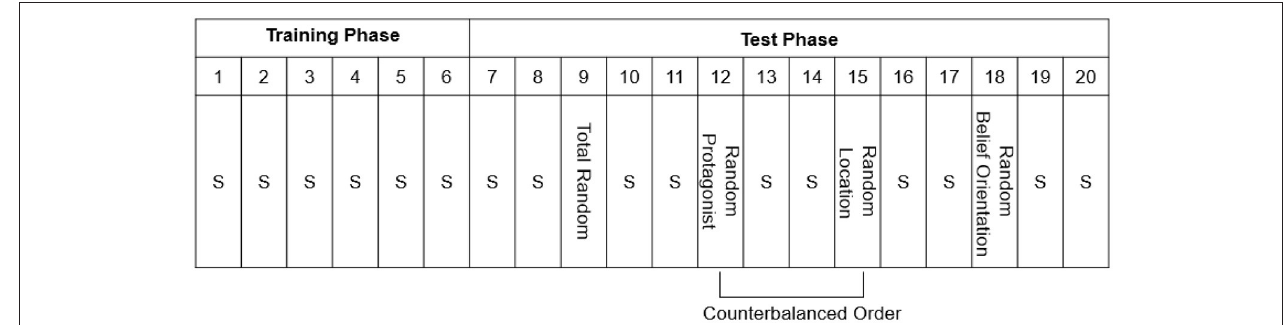
FIGURE 2 | The procedure of Experiment 1, with Blocks numbered 1–20. S = Standard Blocks (with fixed belief-related sequence). Note that every block has a length of 48 trials. One random sequence was created for all dimensions together (i.e., Total Random), and three new sequences were created to test implicit learning of each belief-related dimension (i.e., Random Protagonist, Random Belief Orientation, and Random Location). After the main experiment shown here, there was a recognition test and a post-check question to measure awareness of the embedded sequence.